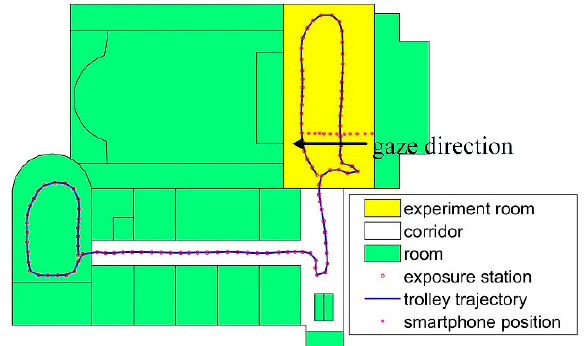
Figure 16. Images are collected along a line.